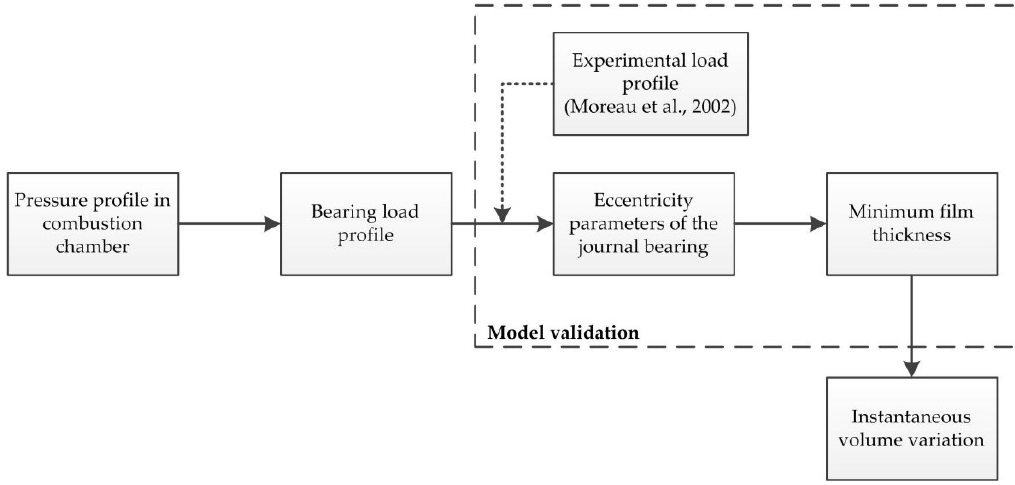
Figure 8. Schematic of the procedure used for the validation of the clearance model.